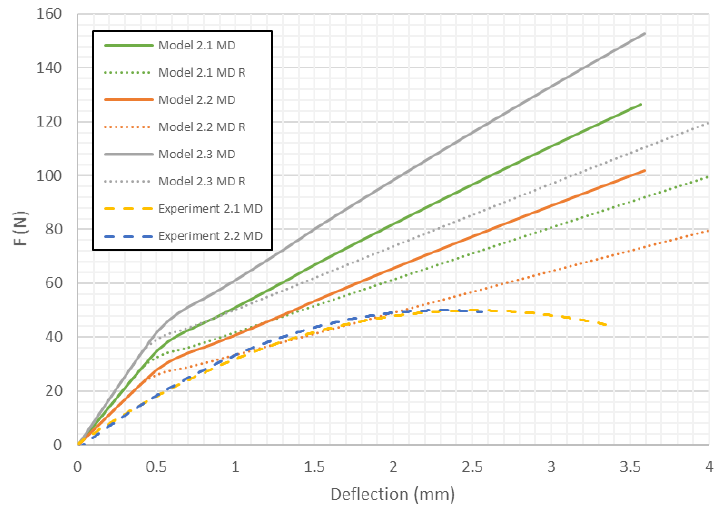
Figure 10. Deflection vs. force for Model 2 in MD.